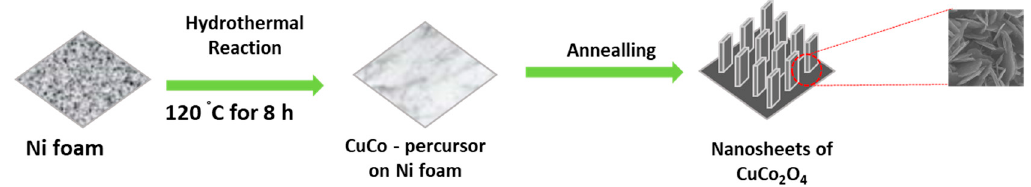
Figure 1. Illustration of the formation of CuCo 2 O 4 on Ni foam.